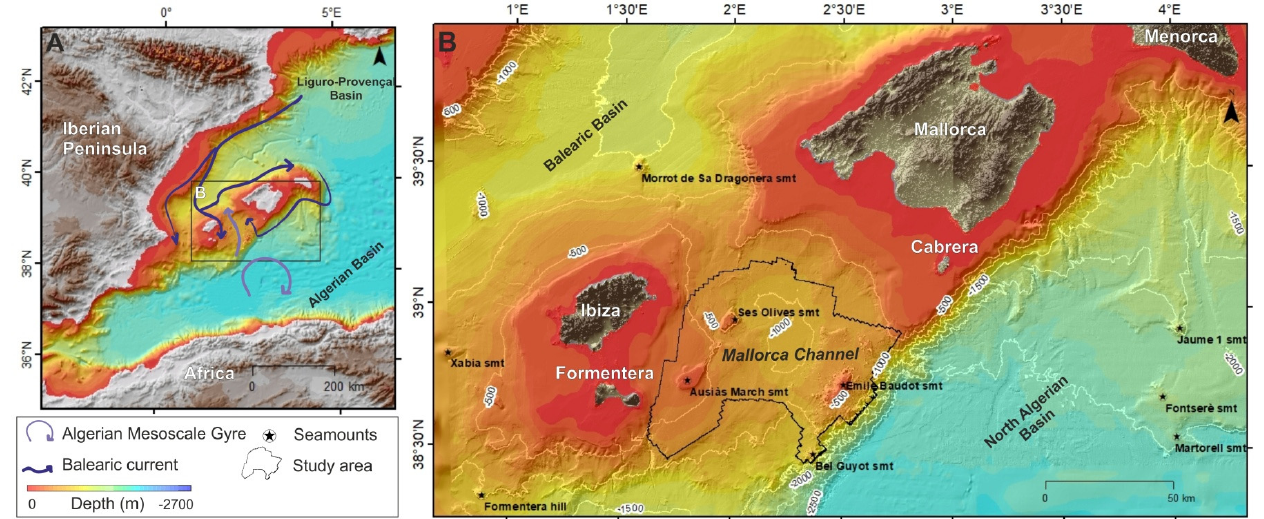
Figure 1. Map of the western Mediterranean showing ( A ) the Balearic Promontory and the ( B ) Ses Olives, Ausias March, and Emile Baudot seamounts and adjacent area of the Mallorca Channel currently studied within the INTEMARES project as well as other seamounts (smt) in the area. The western Mediterranean water mass circulation scheme is modified from López-Jurado et al. (2008).